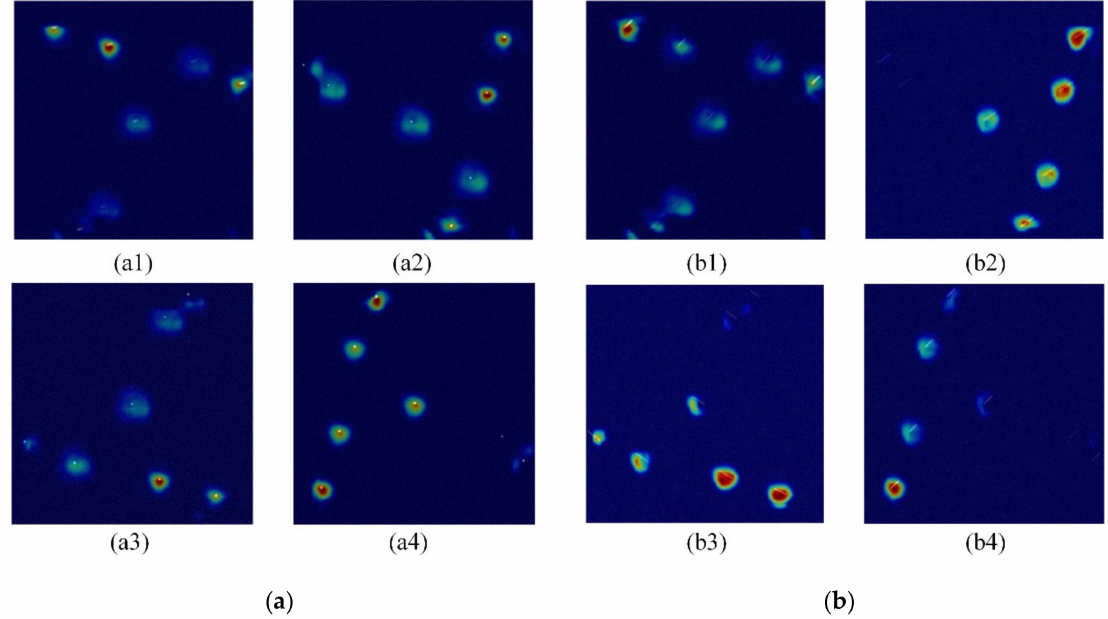
Figure 11. Visualization features for different star maps. Maps ( a ) are with zero angular velocity and maps ( b ) are with two- axis resultant angular velocity of 3 ◦ /s. ( a1 , b1 ) are with roll angles of 30 ◦ . ( a2 , b2 ) are with roll angles of 120 ◦ . ( a3 , b3 ) are with roll angles of 210 ◦ . ( a4 , b4 ) are with roll angles of 300 ◦